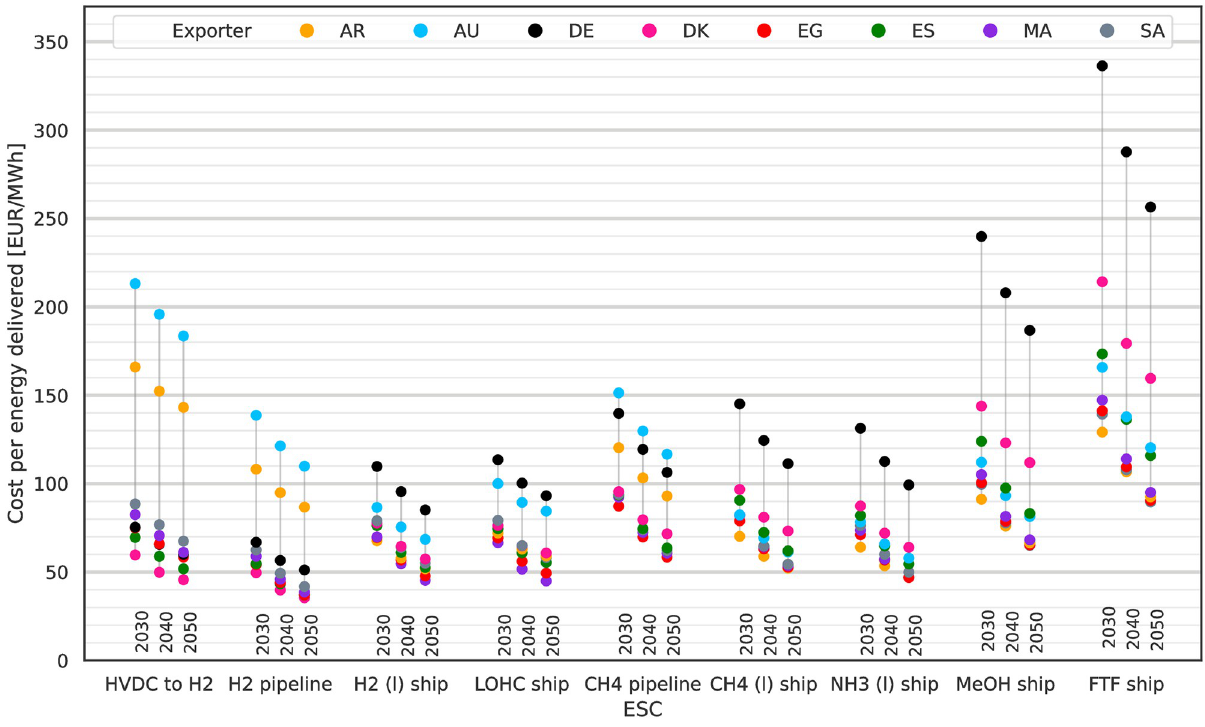
Fig 9. LCoE for 2030 to 2050 at a reduced WACC of 5% p.a.. Lowering the WACC reduces LCoE by around 35%.